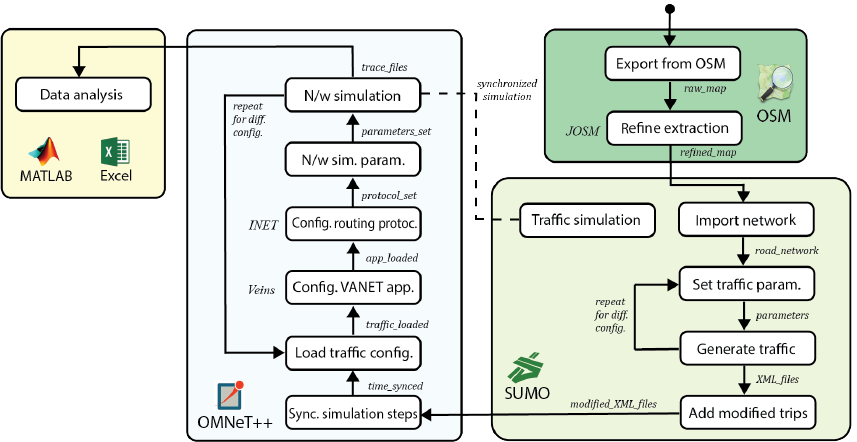
Figure 4. Flow diagram of the simulation